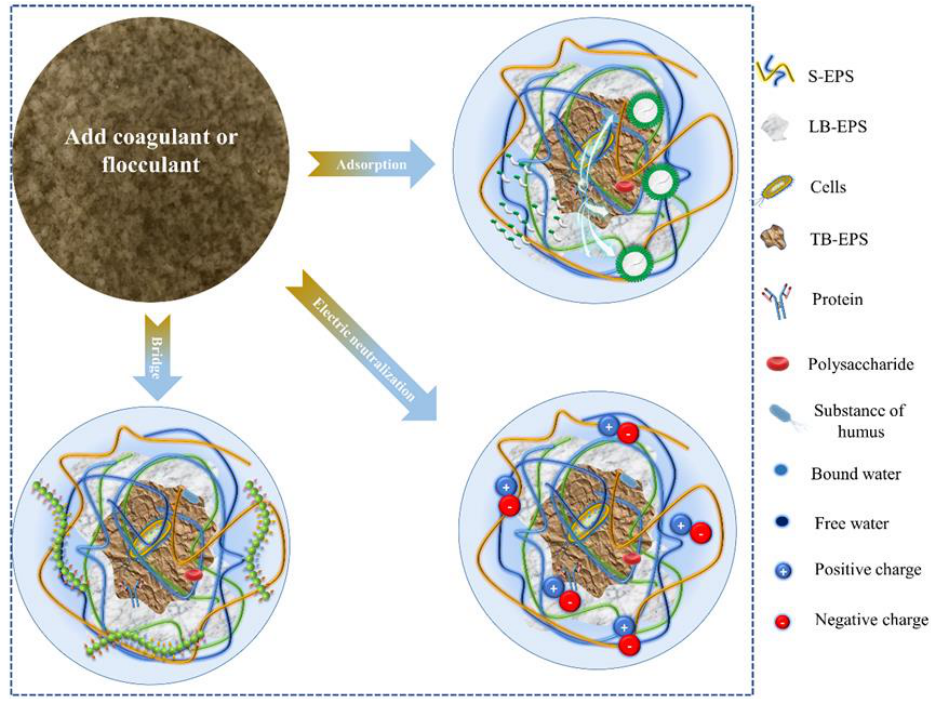
Figure 5. Mechanism of coagulation/flocculation conditioning of sludge.